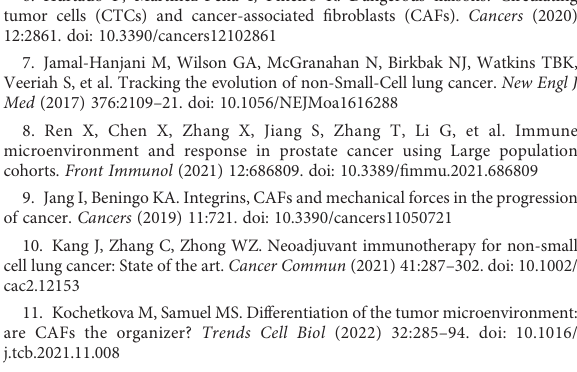
SUPPLEMENTARY FIGURE 1 The fl ow chart of the whole study. SUPPLEMENTARY FIGURE 2 The correlation analysis between CAFs in fi ltration and expression level of